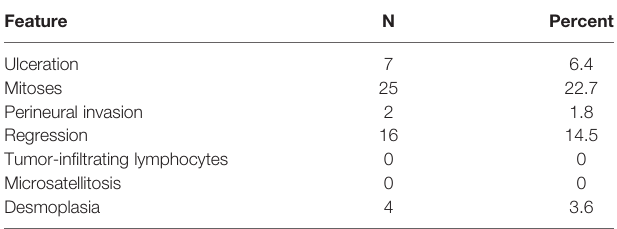
TABLE 2 | Histopathologic features in melanomas of 110 patients.